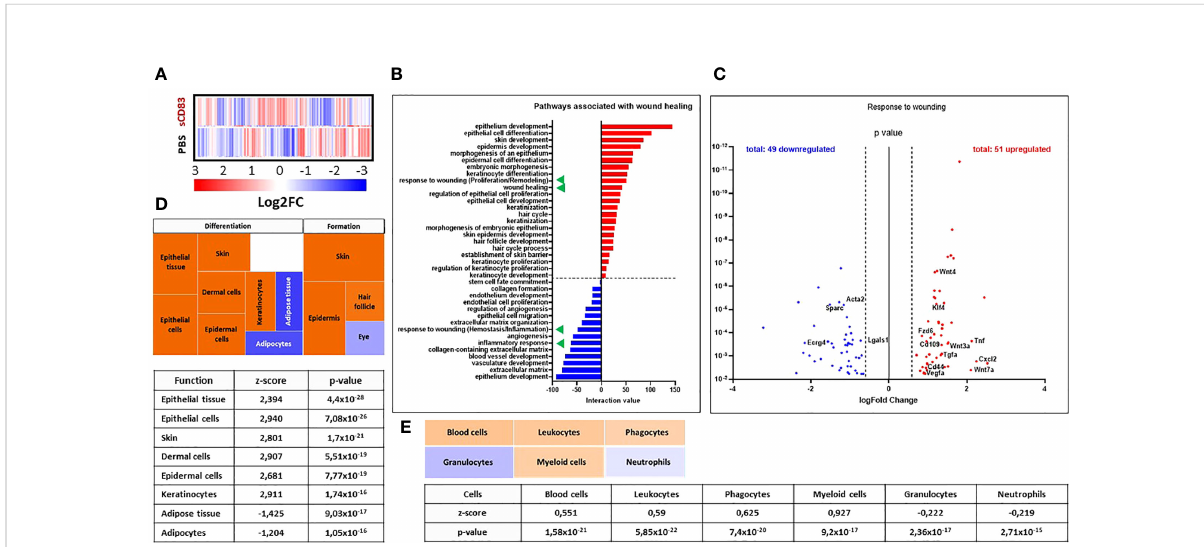
FIGURE 2 sCD83-treatment changes the transcriptome pro fi le towards a wound healing phenotype. RNA was extracted from day 3 wound biopsies and used for RNA sequencing analyses. The transcriptome of sCD83-treated mice was compared to mock controls. (A) Representative heat map of differently expressed transcripts in wound biopsies of sCD83-treated and PBS-treated mice on day 3: induction = red and suppression = blue (each n=2). (B) Pathway analysis was performed based on the transcriptome analyses and its interaction value with the corresponding pathways (red = induced and blue = suppressed). Green triangles highlight two wound healing-associated pathways that were induced or suppressed by sCD83, respectively. (C) Volcano plot of RNA sequencing analyses of wound biopsies of sCD83- vs. PBS-treated mice on day 3 included in the response to wounding pathway. Dots depicted on the right-hand side of the logFold change 0 value represent signi fi cantly upregulated gene transcripts (red), while the dots on the left-hand side represent signi fi cantly downregulated transcripts (blue) with logFC ≥ 0.585, respectively. The Y-axis depicts the p value. (D) Transcriptome data were further analysed using the Ingenuity Pathway Analysis (IPA) software from QIAGEN ’ s revealing enhanced wound healing pathways in sCD83-treated mice. (E) Cellular composition within day 3 wound sites of sCD83-treated mice as assessed from the RNA sequencing data by